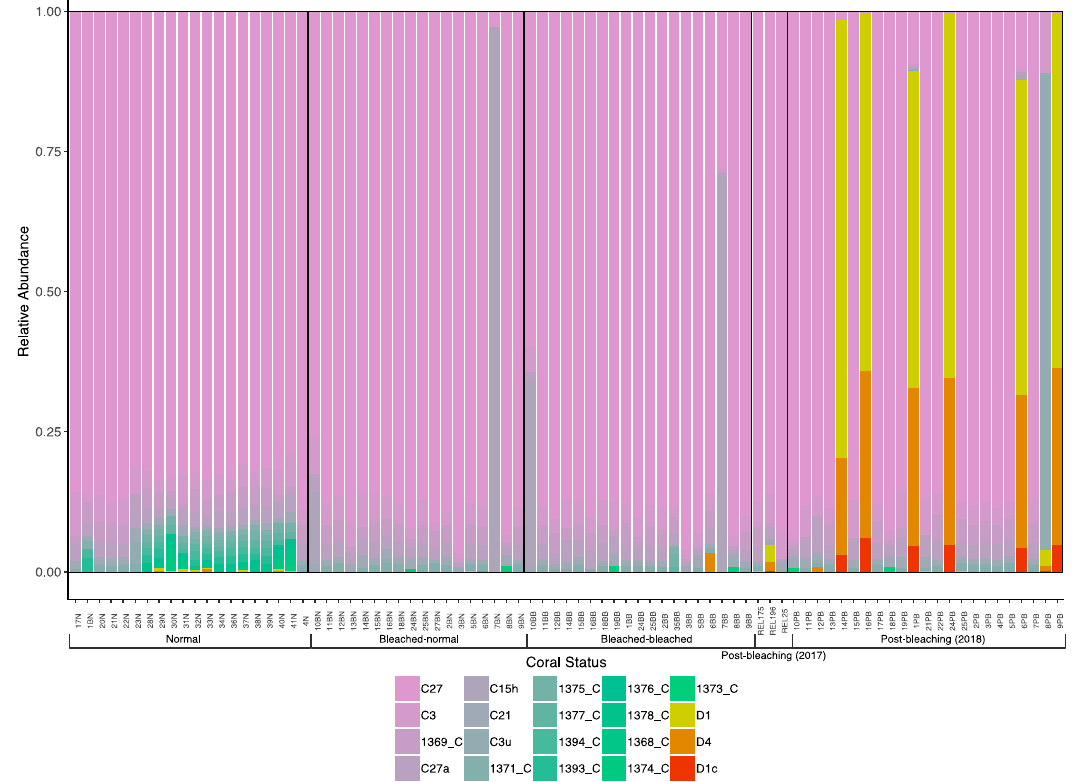
Figure 4. Diversity and relative abundances of Symbiodiniaceae types among all the colonies of Pachyseris speciosa analyzed.